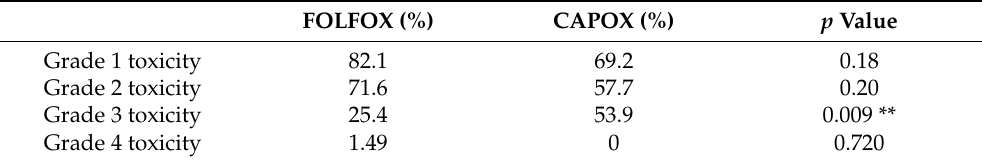
Table 4. Proportion of Patients Experiencing One or More Chemotherapy-Induced Toxicities by Severity.